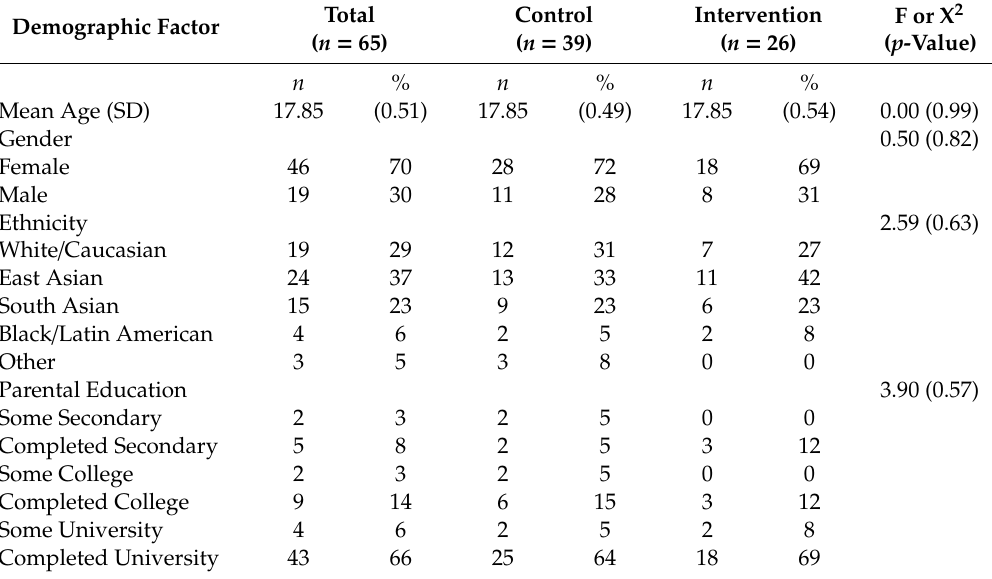
Table 1. Participant Characteristics and